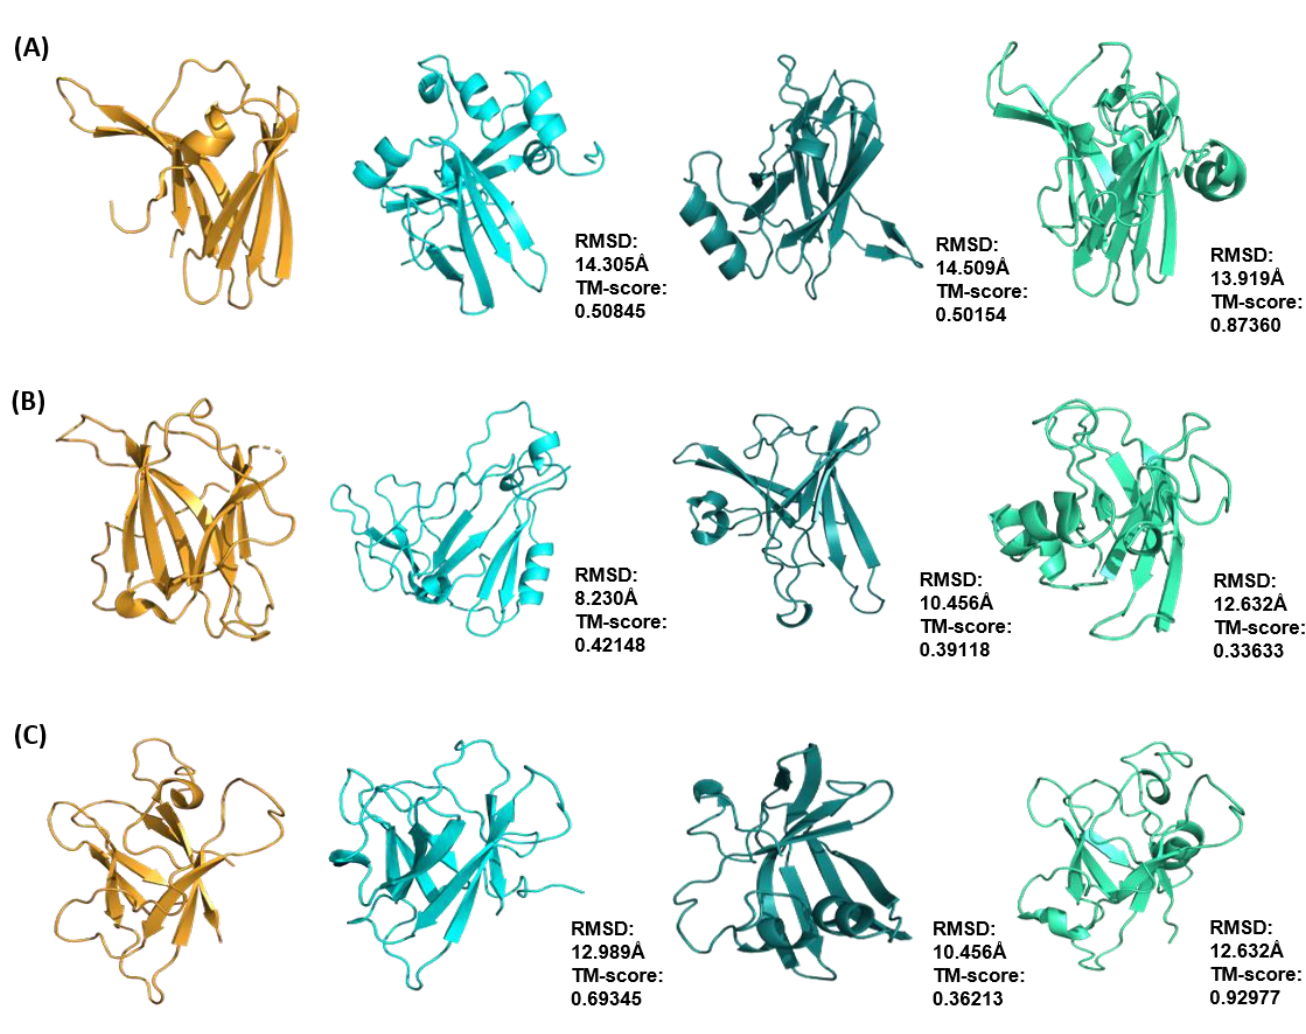
Figure 7. Comparison of Rosetta ab initio models of ToxA-like family (shown in cyan) ToxA ( A ), Avr2 ( Fol ) ( B ) and AvrL567 ( C ) with models generated with Robetta (shown in dark green) and QUARK (shown in light green). Each model was superimposed onto its respective XRD or NMR structure (shown in gold) and the corresponding RMSD and TM-score values are shown to the right-hand side of each model.